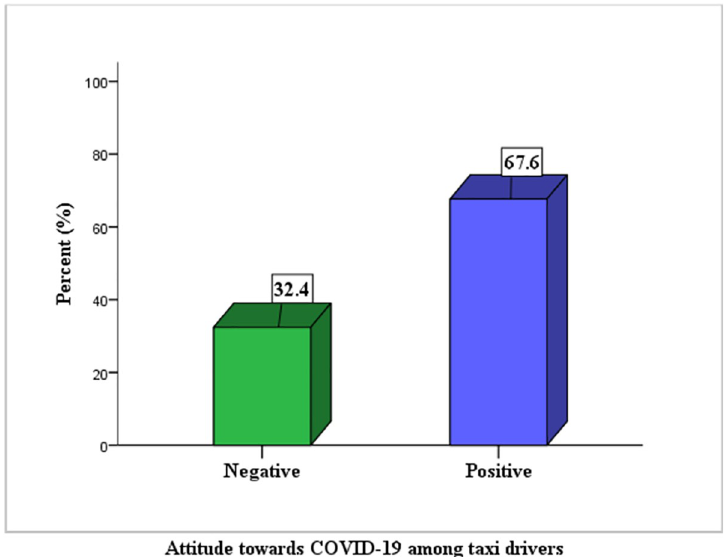
Fig 2. Attitude towards COVID-19 prevention among taxi drivers in Dessie City and Kombolcha Town, Ethiopia, July to August 2020.